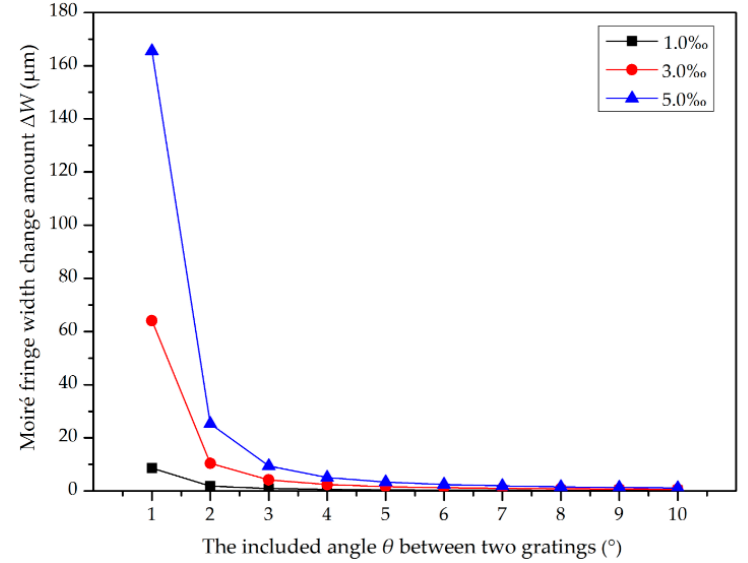
Figure 3. Curve of fringe width with focal length difference.